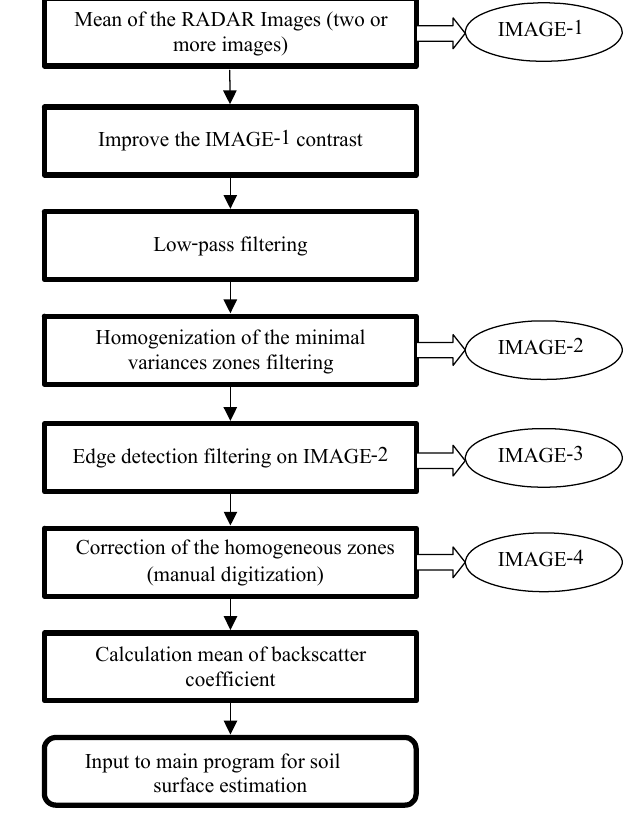
Fig. 15. Flowchart of homogeneous zone